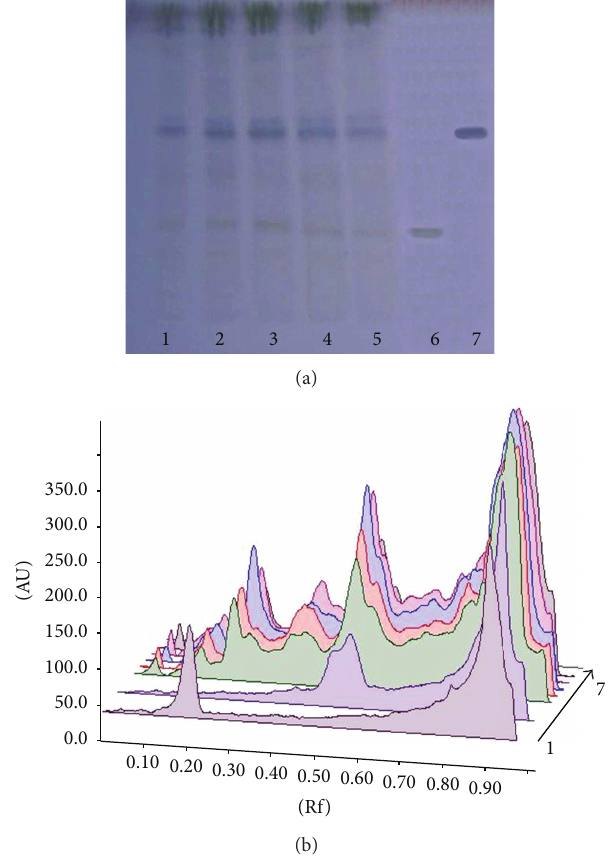
Figure1:TLCofmethanolicextractofcontrolandCdtreatedplants of Bacopa monnieri . (a) Fingerprint profile, 1: control, 2: 5 𝜇 M Cd, 3: 10 𝜇 M Cd, 4: 50 𝜇 M Cd, 5: 100 𝜇 M, 6: bacoside A, and 7: bacopaside I. (b) Densitometric scan at 500 nm.